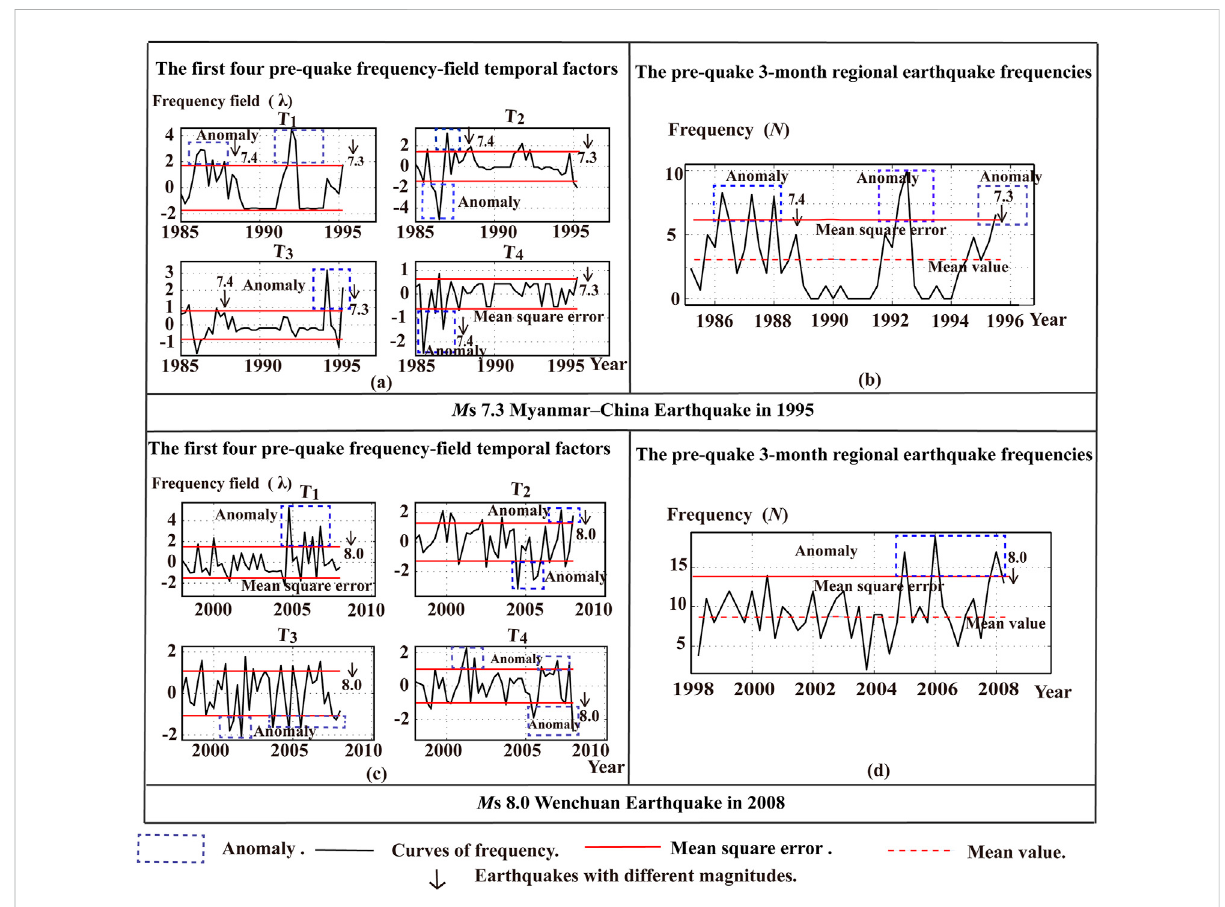
FIGURE 5 Comparison between frequency- fi eld temporal factors and regional earthquake frequency graphs, the green dotted line represents the anomaly,theredlineistwotimesthemeansquareerror,theblackarrowrepresentsthemagnitudeofa M s ≥ 7.0earthquake,thereddottedlineisthe mean line (A,B) the 1995 M s 7.3 Myanmar – China earthquake (top), (C,D) the 2008 M s 8.0 Wenchuan earthquake